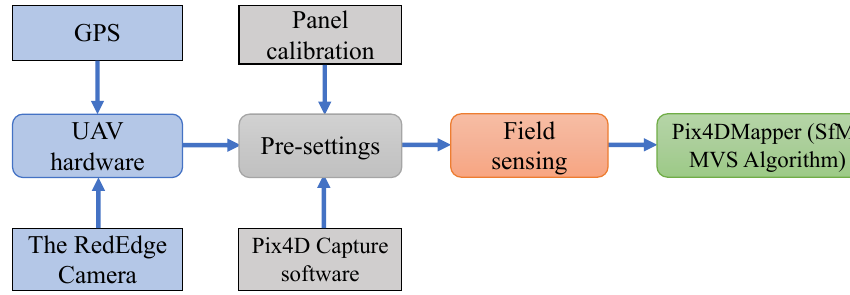
Figure 4. colorblueFlowchart of UAV based multispectral imaging